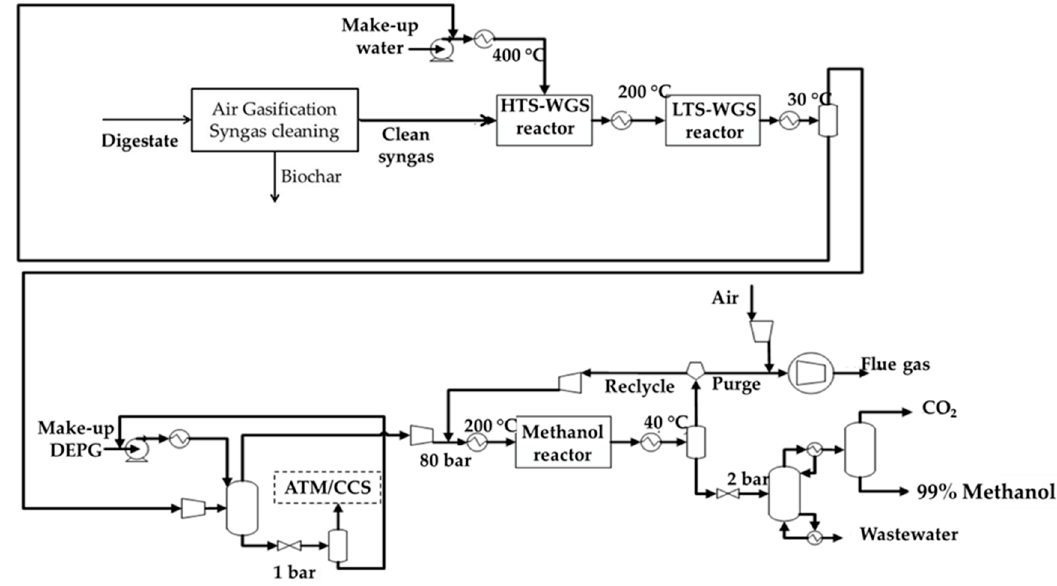
Figure 3. Flowsheet of valorization of digestate for producing methanol.